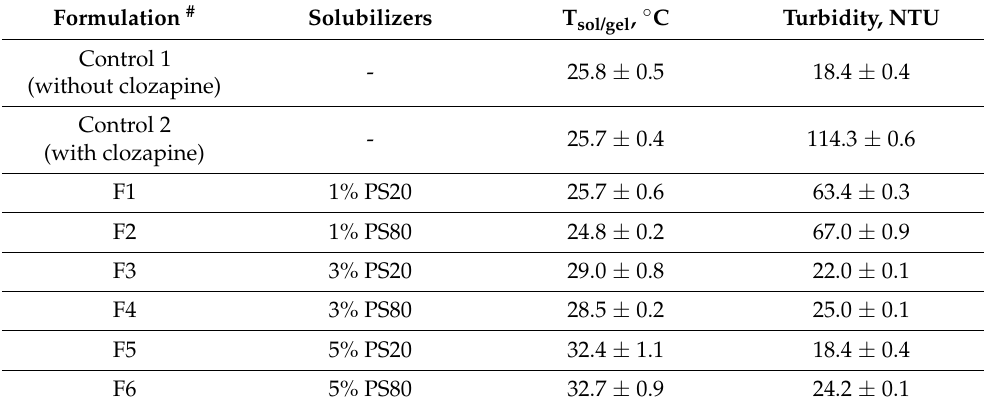
Table 3. Formulations containing a range of PS20 and PS80, and their respective T sol/gel and NTU values. Formulation